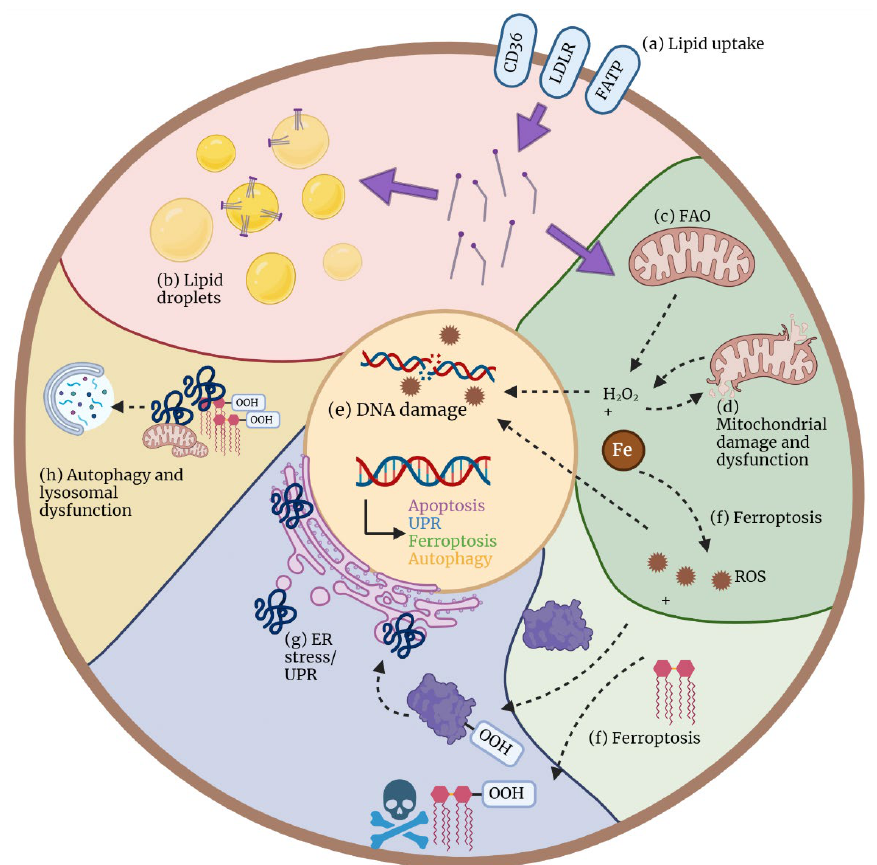
Figure 4. Mechanisms of lipotoxicity. Excessive lipids, especially free fatty acids (FFAs), are frequently present in the TME. ( a ) FFAs can be taken up into the cell via specific transporters, such as CD36, LDL receptor (LDLR) and fatty acid transporter proteins (FATPs). Once in the cytoplasm, FFAs have different fates and might cause lipotoxicity via different mechanisms, which are often interconnected. ( b ) To prevent lipotoxicity, FFA can be stored in lipid droplets as triglycerides (TGs) for later use or simply as a protective mechanism (pink). Excess FFAs in the cytoplasm trigger the following effects: ( c ) FFAs can be transported into the mitochondria to fuel FAO and, subsequently, oxidative phosphorylation (OXPHOS). One of the products of these reactions is hydrogen peroxide (H 2 O 2 ), one of the most abundant reactive oxygen species (ROS) that can lead to oxidative stress, mitochondrial ( d ) and DNA damage ( e ), and, subsequently, cell death. ( f ) Excessive ROS in the presence of iron (Fe) can lead to lipid and protein peroxidation and, subsequently, a recently described type of regulated cell death termed ferroptosis. ( g ) Protein peroxidation, among other processes, leads to the accumulation of misfolded proteins in the endoplasmic reticulum (ER), which causes ER stress and triggers the unfolded protein response (UPR). ( h ) Misfolded proteins, oxidized lipids, and malfunctional organelles are eliminated in the lysosomes via the process of autophagy,